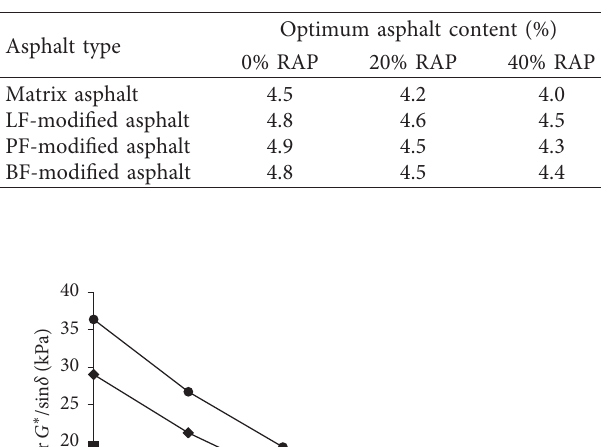
Table 6: The optimum asphalt content of different asphalt mixtures.